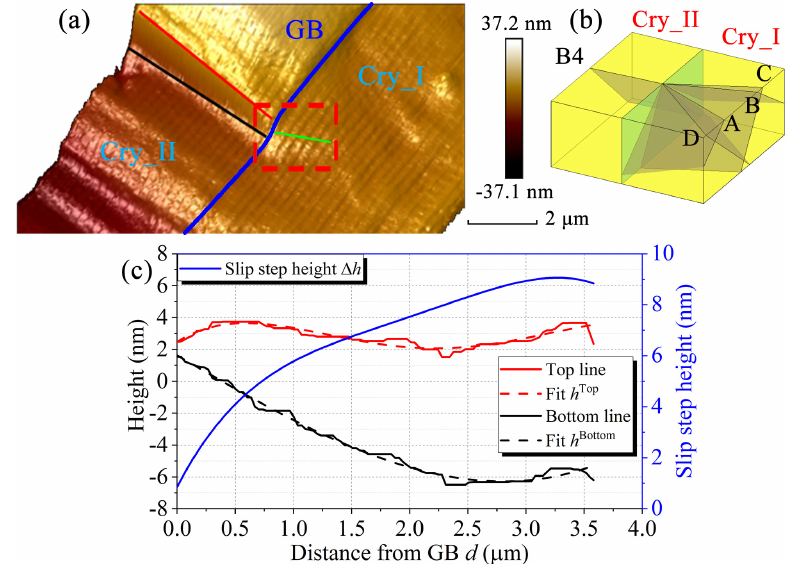
Figure 5. ( a ) ex-situ AFM topographic measurement for the Ni sample. The transmission phenomenon and/or dislocation absorption at GB are surrounded by the frame with red dashed lines. The green line indicates the direction of slip transmission. By comparison of this direction with the schematic presentation of the four slip planes